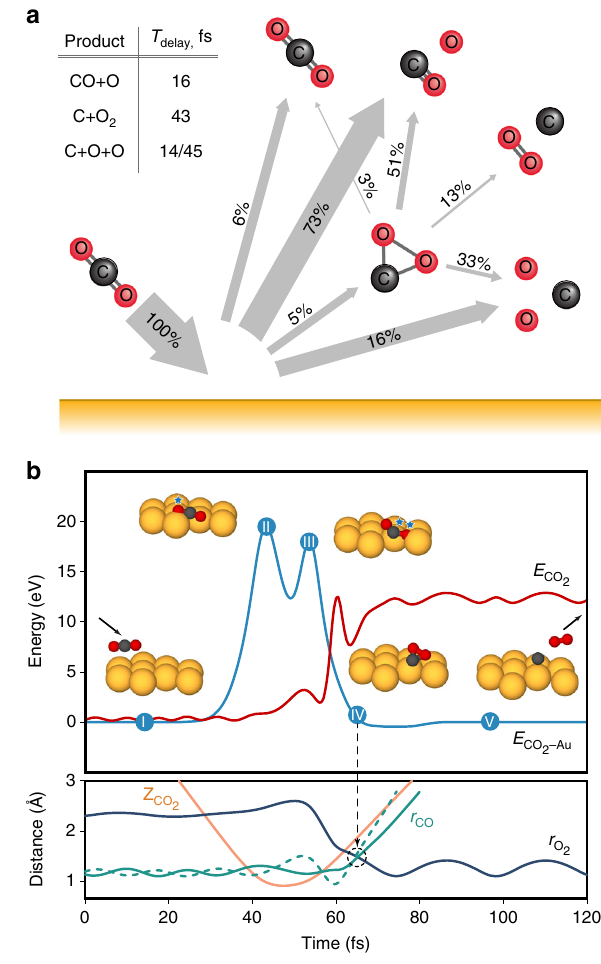
Fig. 3 Product yields and energetics of CO 2 scattering on Au. a Calculated yields of neutral dissociation products from a statistical analysis of an ensemble of CO 2 scattering trajectories on Au(111) at E 0 = 56.4 eV. Inset: average delay times ( T delay ) of the dissociation channels relative to the point of closest approach of CO 2 to the surface. b Energetics along an illustrative CO 2 collision trajectory, which leads to O 2 formation on Au at E = 56.4 eV. Curve identi fi cation: CO – Au interaction energy (light blue), 0 2 CO 2 potential energy (red), CO 2 center-of-mass distance from the metal surface (orange), O – O bond length (dark blue), and C – O bond lengths (full and dashed green lines). Insets I – V: Select con fi gurations of the CO 2 surface geometry along the scattering